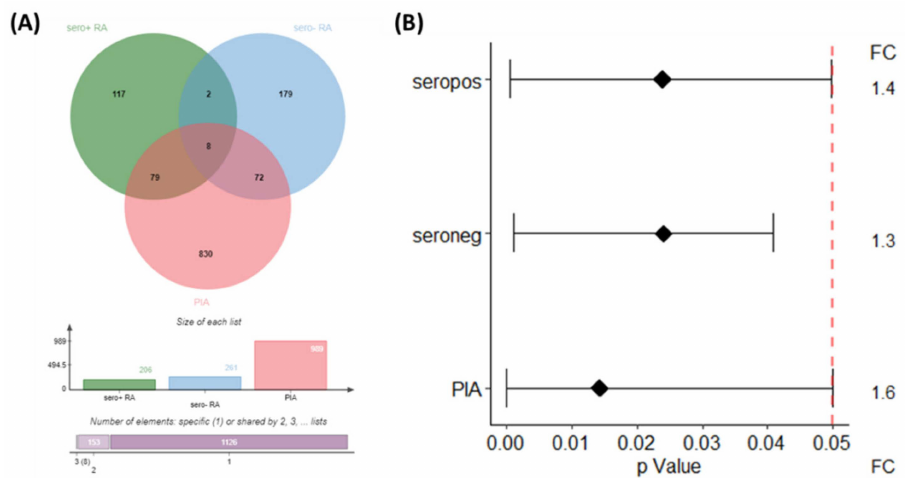
Figure 3. Intersection of significant higher reactive DIRAGs as Venn Diagram ( A ) and their respective p -values and the average fold-change as a forest plot ( B ). Results of the blocked analysis of the comparison seropositive versus seronegative RA was used, and PIA 7 vs. 24 days after correction for DIRAGs higher reactive in PBS animals. VennDiagram created with JVenn